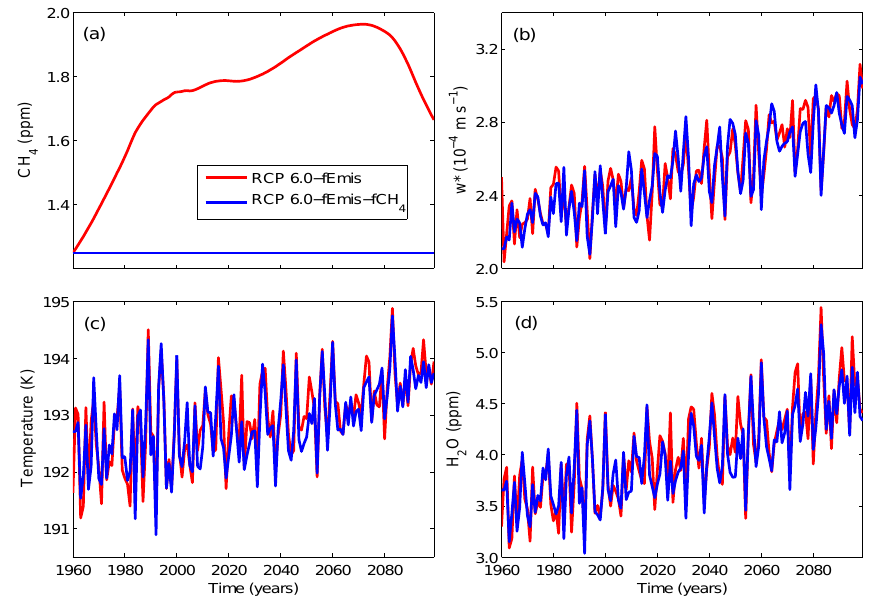
Figure 4. Drivers of SWV change in the RCP 6.0-fEmis and RCP 6.0-fEmis-fCH 4 simulations. (a) Global-mean and annual-mean surface methane concentrations. (b) Annual-mean rate of the vertical residual circulation at 70hPa, 20 ◦ N–20 ◦ S. (c) Annual-mean tropical CPT temperatures, 20 ◦ N–20 ◦ S, 90hPa. (d) Annual-mean stratospheric entry water vapour at 80 hPa, 20 ◦ N–20 ◦